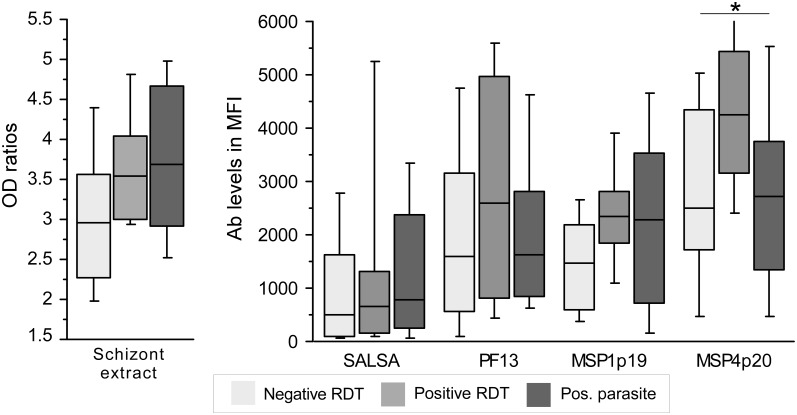
Ab responses as function of presence of circulating parasites in asymptomatic group recruited in 2011.Levels of Ab responses against schizont extract, SALSA, PF13, MSP4p20 and MSP1p19 are illustrated as boxplot for asymptomatic individuals recruited in 2011 as function of their parasite carriage ie RDT negative, RDT positive, RDT and blood smear positivity. Significant differences (Kruskal wallis test, P<0.05) are indicated by an asterisk.